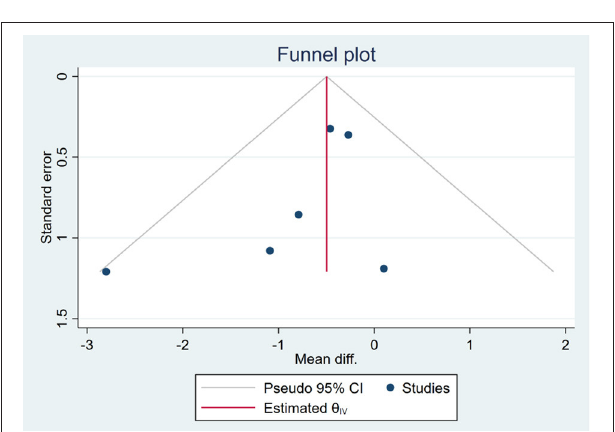
FIGURE 17 | Funnel plots of the effect of body weight (BW).